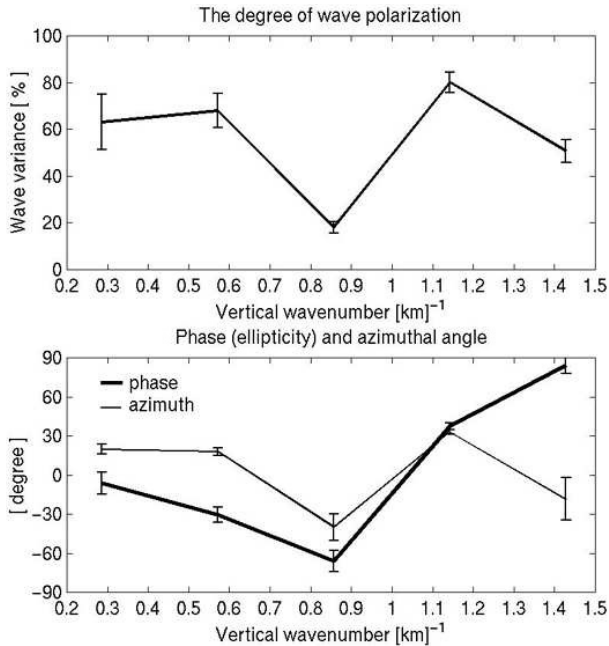
Fig. 11. Hodograph analysis of Andenes wind disturbances be- tween 70–90km at 22:00 UT on 10 August